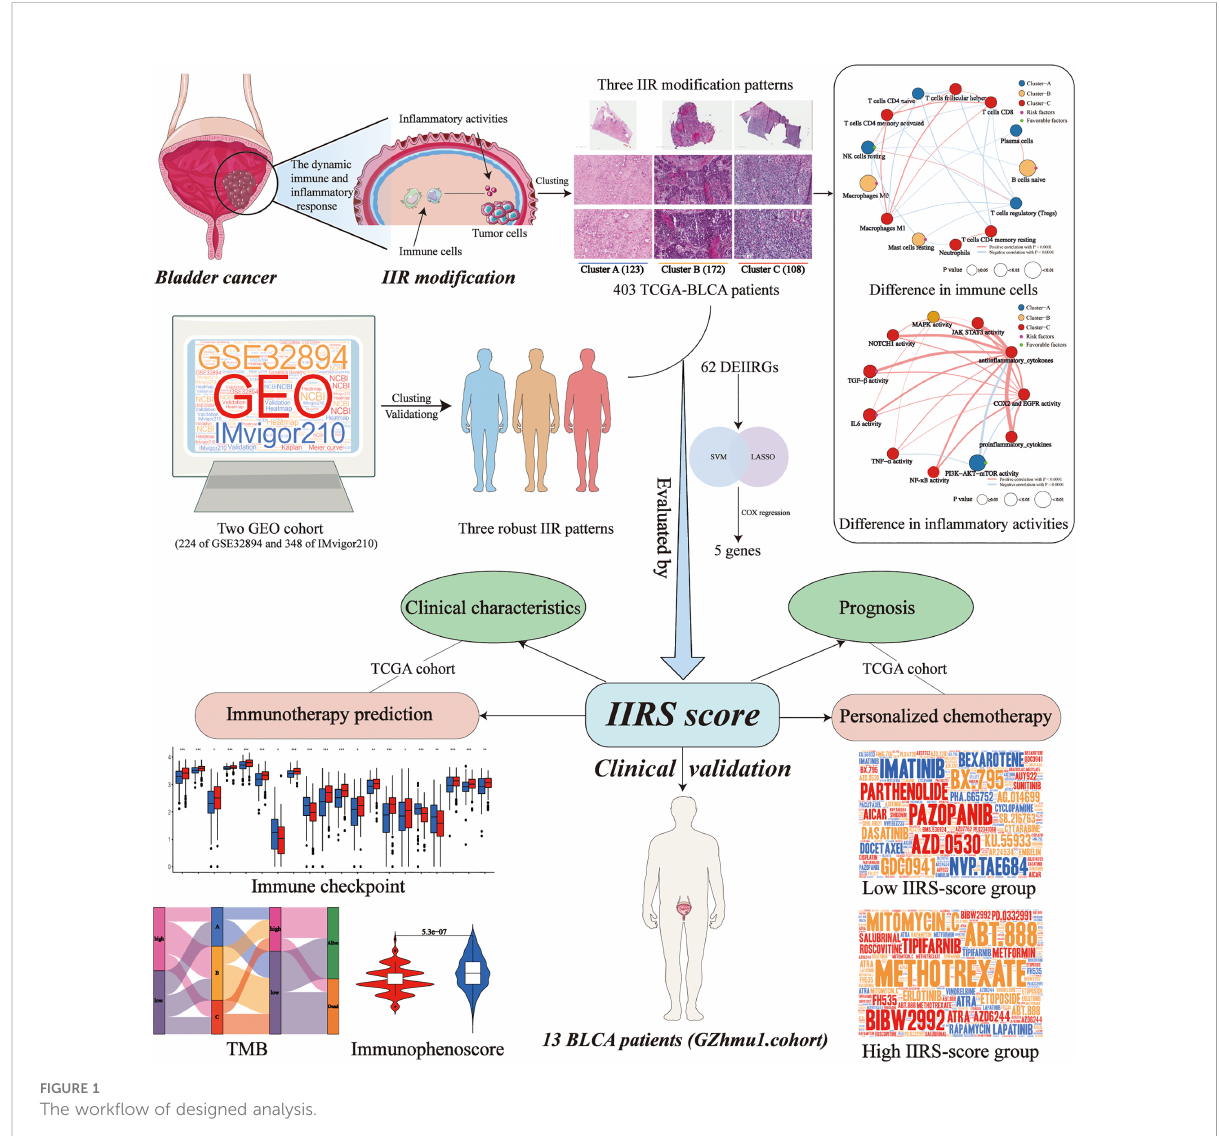
FIGURE 1 The work fl ow of designed